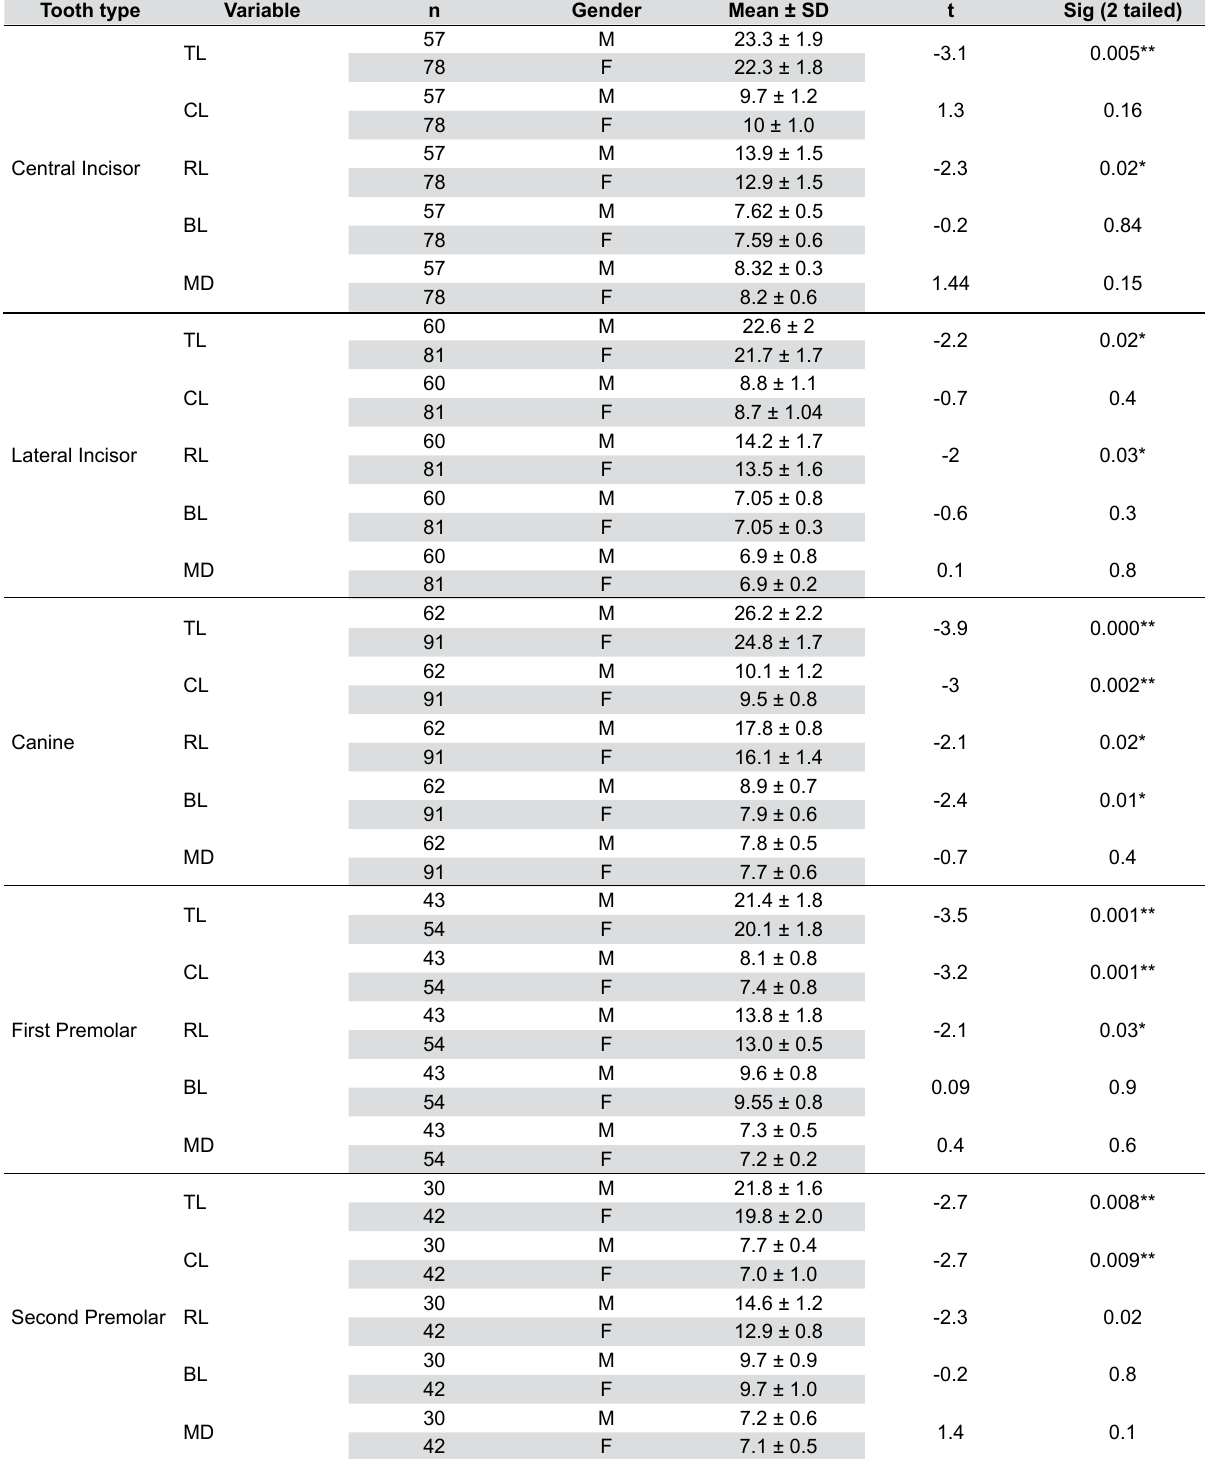
Table 1- Comparison of tooth length measurements between male and female subjects